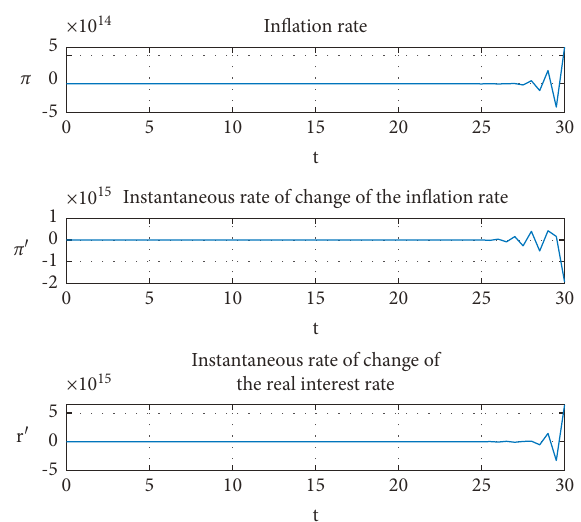
Figure 17: Time paths of the interest rate and instantaneous rates of change of inflation and the interest rate (for I 1 and with β 1and β β 0 (cid:31) (cid:31) (cid:31)